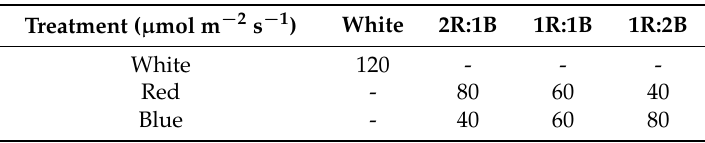
Table 4. Light treatment